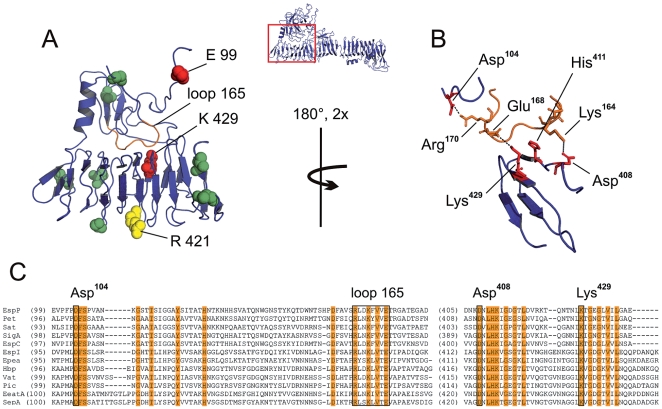
Transport activity of inserts in the N-terminal part of the passenger domain.A. Ribbon diagram of junction between Domain 1 and β-helix. Localization of this region is illustrated in the overview of the passenger domain. Insert positions of linker mutants in the junction are highlighted by coloured spheres, indicating transport activity of the respective constructs (red: transport-inactive, yellow: residual activity, green: activity comparable with wild-type). Constructs displaying loss of function are highlighted by construct names. Loop 165 is marked in orange. B. Detailed representation of interactions leading to stabilisation of the junction region (twofold magnification, view rotated 180°). Salt bridges are indicated by dashed lines, residues involved in stabilising interactions are named and illustrated in stick representation. Loop 165 is given in orange. C. Sequence alignment of residues in SPATE proteins forming the junction region. Overall conserved residues are highlighted in orange. Residues mediating inter-domain interactions as described in B are named and marked by black frames. Key residues involved in interaction are highly conserved in SPATE proteins.